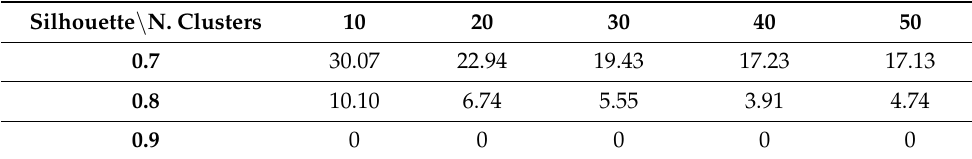
Table 41. Clustering performance in terms of silhouettes using the reduced dataset with PCA applied to normalized data. Silhouette \ N. Clusters